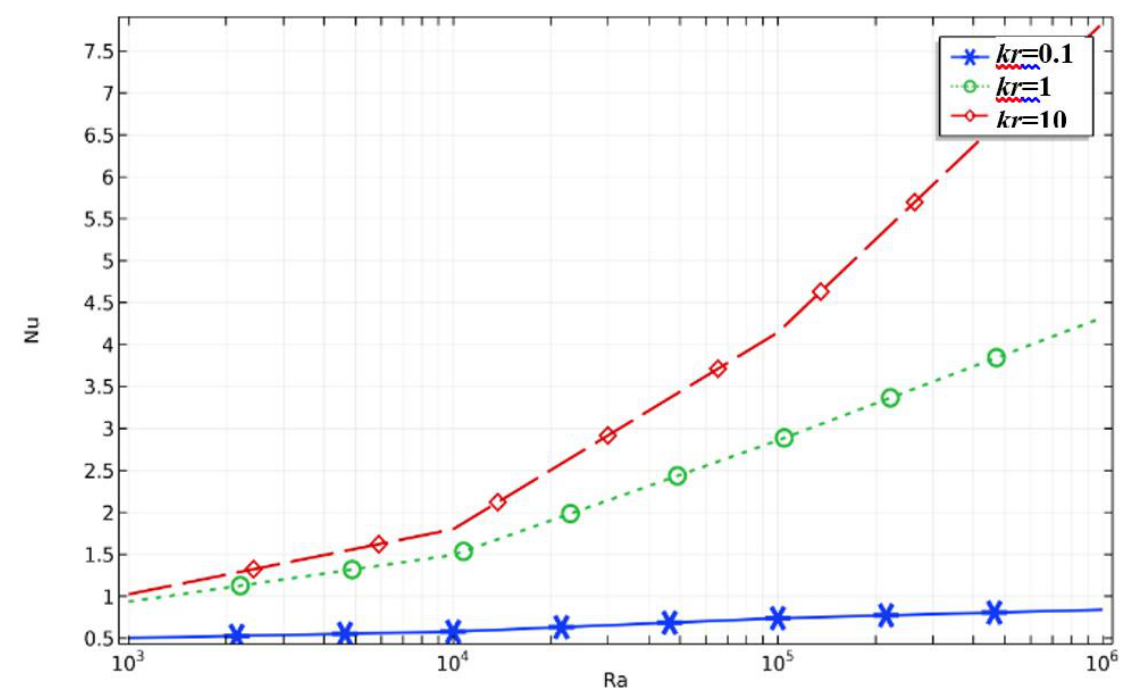
Figure 10. Average Nusselt number at various 𝑅𝑎 and 𝐾𝑟 of the solid wall at = 90 𝑎𝑛𝑑 𝜙 = 0.06.